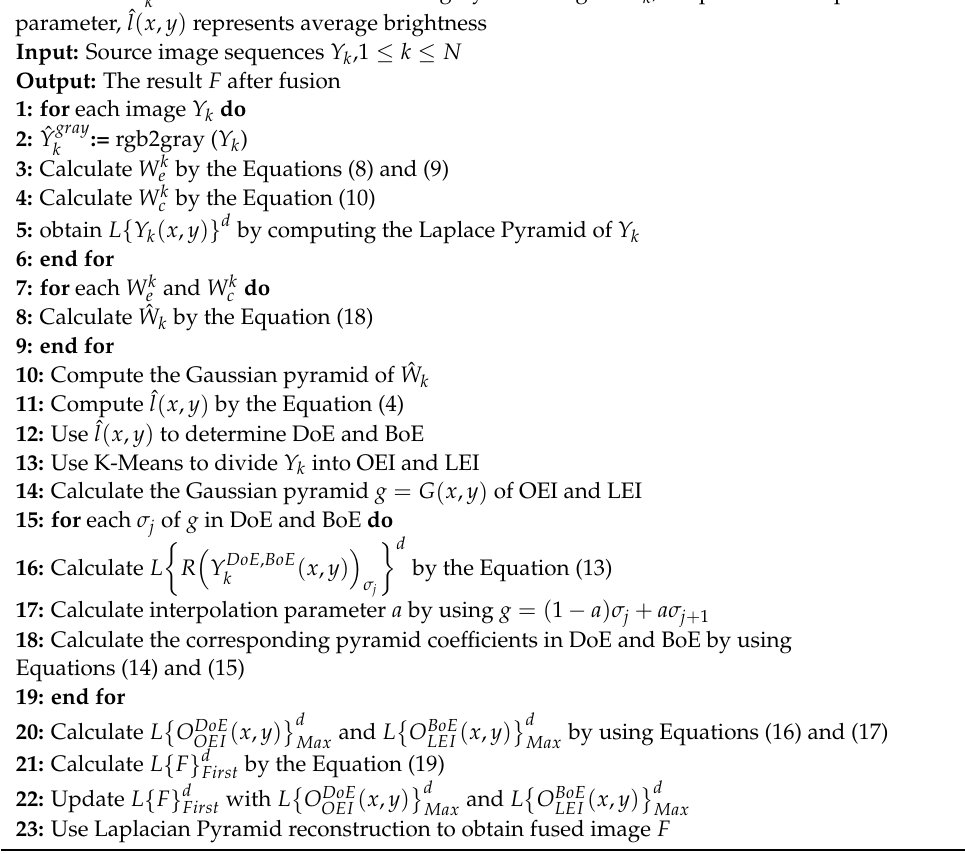
Algorithm 1: The proposed